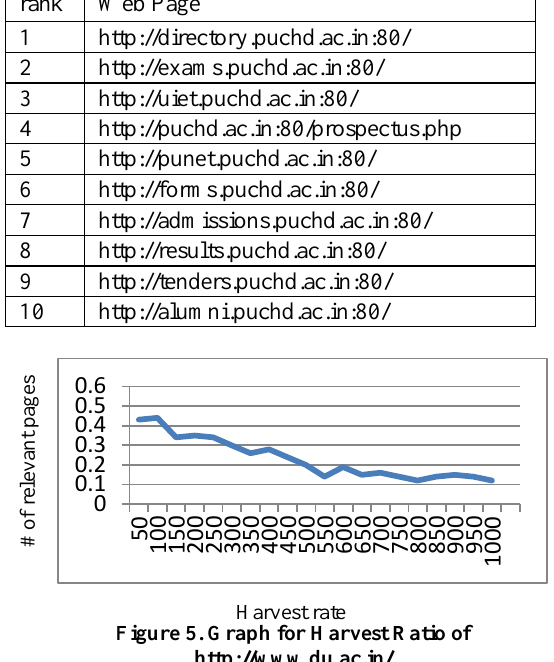
Figure 5. Graph for Harvest Ratio of